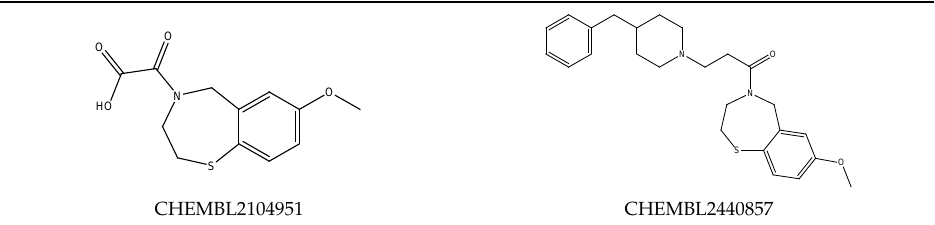
Table 2. Chemical structure of compounds CHEMBL2104951 and CHEMBL2440857.